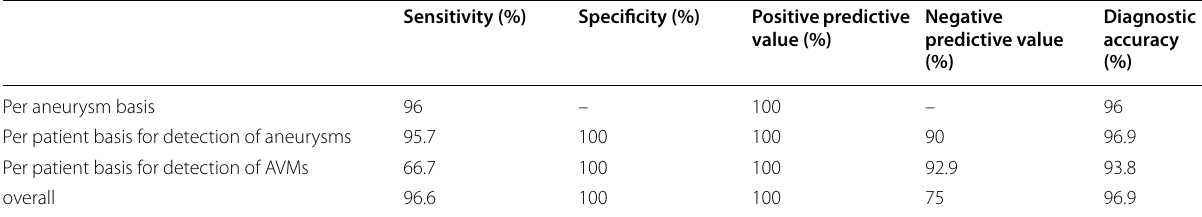
Table 3 Diagnostic efficacy of CTA compared to DSA (gold